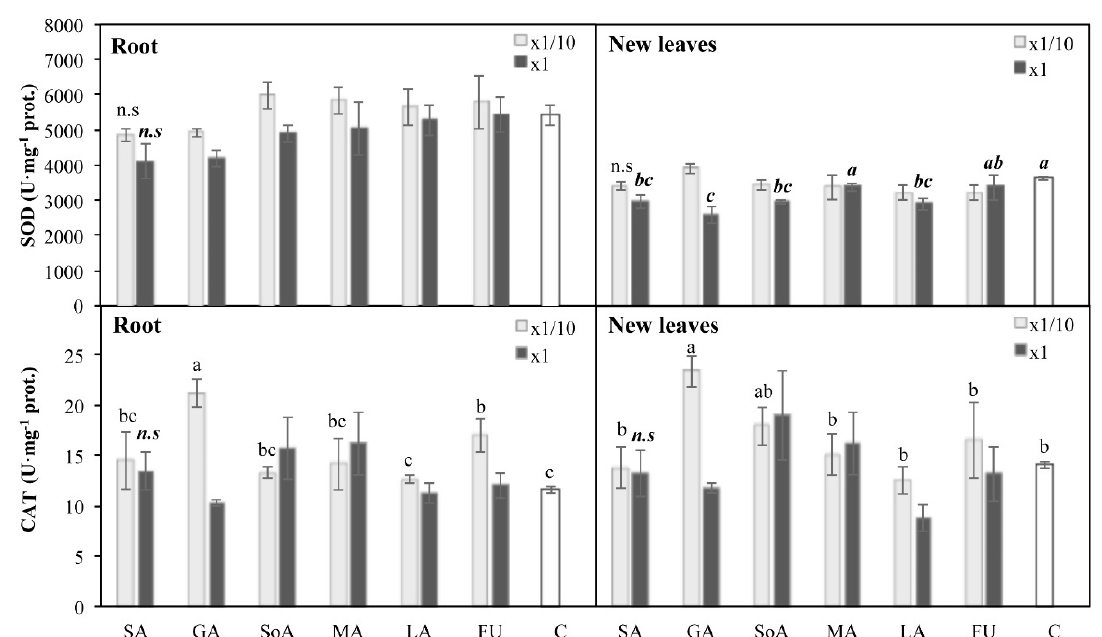
Figure 5. Oxidative stress indexes (SOD and CAT activity) of root and new leaves of tomato plants treated with organic compounds (salicylic acid (SA), gallic acid (GA), sodium alginate (SoA), mannitol (MA), laminarin (LA), and fucose (FU)) at two concentrations (×1/10 and ×1) and after six days of Fe deficiency. A control (C) treatment without organic compound application was performed. Data are means ± SE ( n = 3). Significant differences between treatments ( p < 0.10) are indicated by different letters (regular letters for ×1/10; cursive bold letters for ×1). Not significant differences between treatments are indicated by n.s.